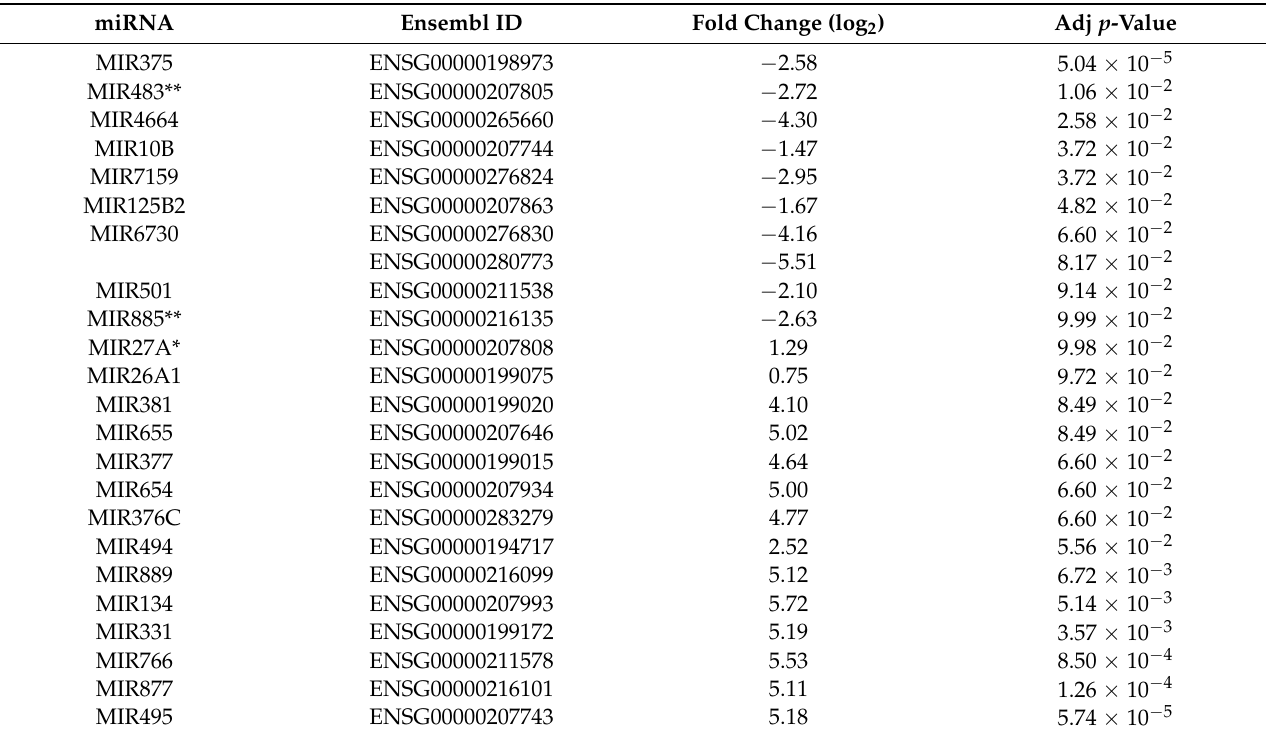
Table A1. Differential expression of miRNAs in the plasma of premutation vs. control donors. Potential common genes with a previous report comparing the whole blood profiles from FXTAS patients vs. control donors [75] are indicated as * (upregulation) or **